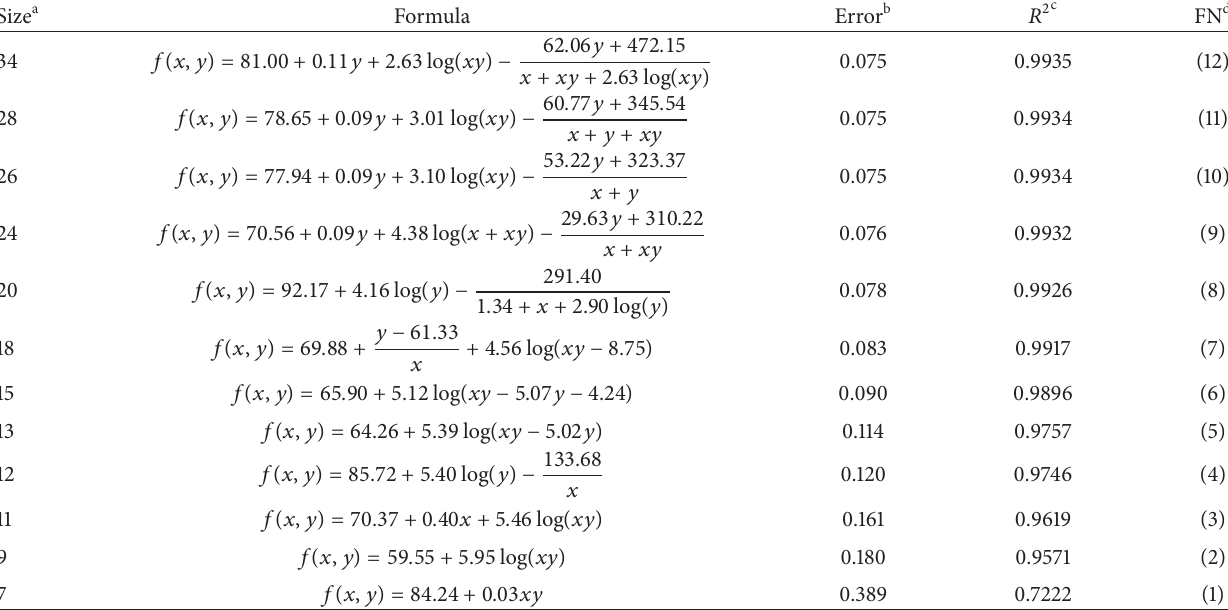
Table 2: The formulas distilled by Eureqa based on the simulation results of CR.